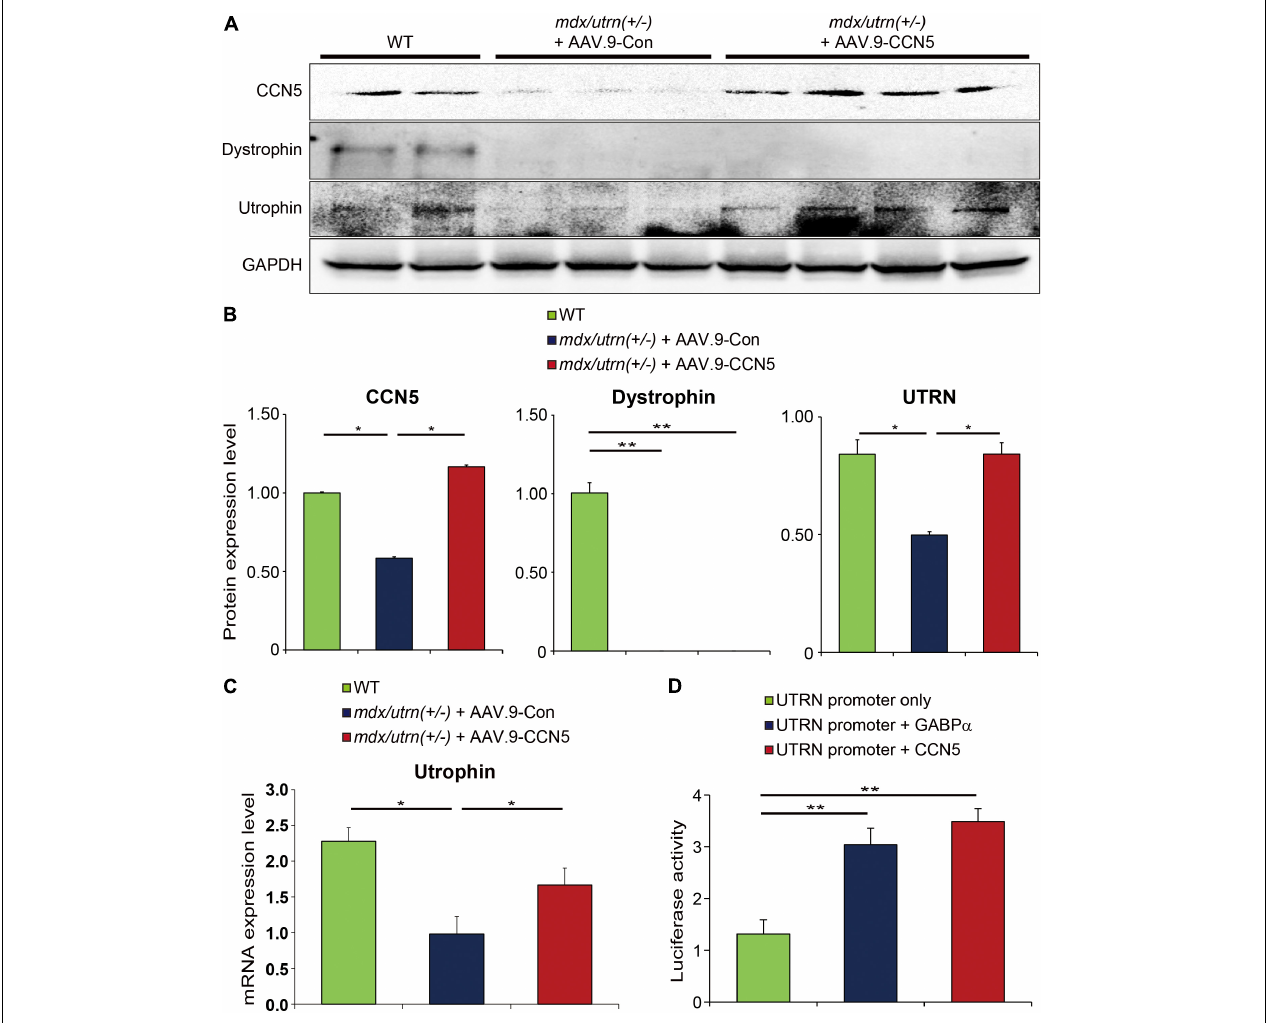
FIGURE 4 | CCN5 directly regulates utrophin expression. (A) Proteins obtained from cardiac tissues were immunoblotted with antibodies against CCN5, dystrophin, utrophin and GAPDH. (B) Protein bands on western blots were scanned and plotted. (C) Relative mRNA expression level of utrophin in hearts. (D) Utrophin (UTRN) promoter only, UTRN promoter + GABP α , and UTRN promoter + CCN5 were transfected to 293T cells. Luciferase activity was measured 72 h later. Luciferase activity was analyzed by GloMax Microplate Reader. n = 6 for western blots. n = 4 for luciferase assay. * p < 0.05 and ** p <